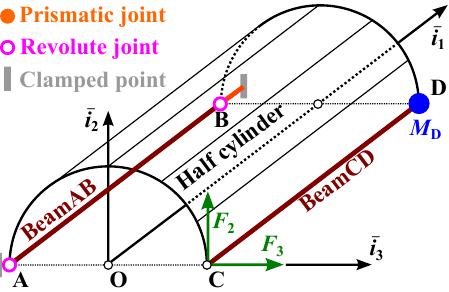
Figure 10. Configuration of the half-cylinder